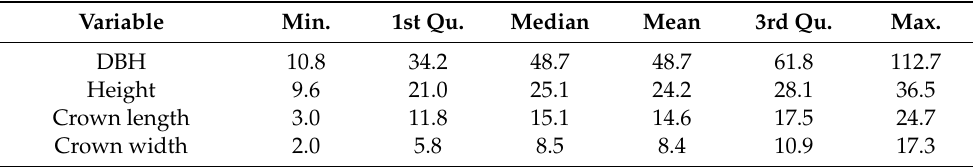
Table 1. Characteristics of the sample